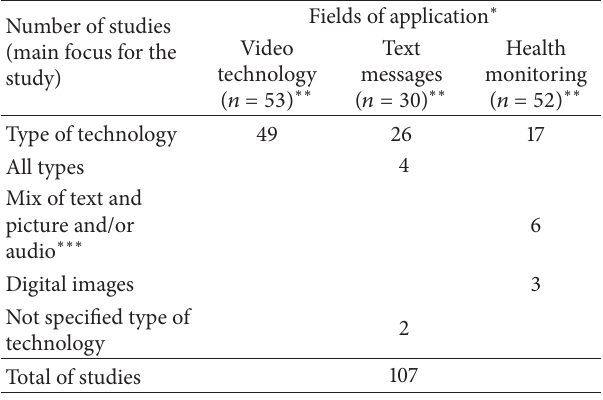
Table 4: Overview of ICT applications used in